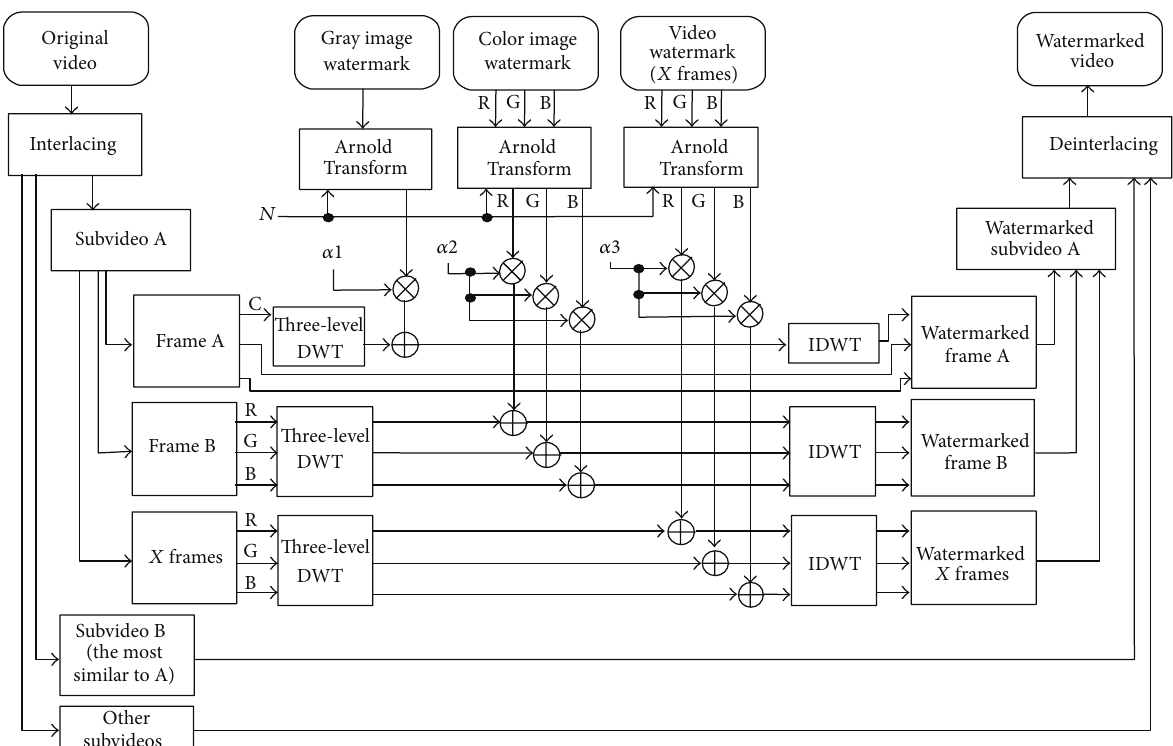
Figure 4: The watermark embedding process in the proposed video multiple watermarking system, where RGB stands for red, green, and blue color bands, N is the number of Arnold Transform iterations, 𝛼 is the scaling factor, C is the selected color band, A and B stand for the most similar subvideos, and DWT stands for discrete wavelet transform.